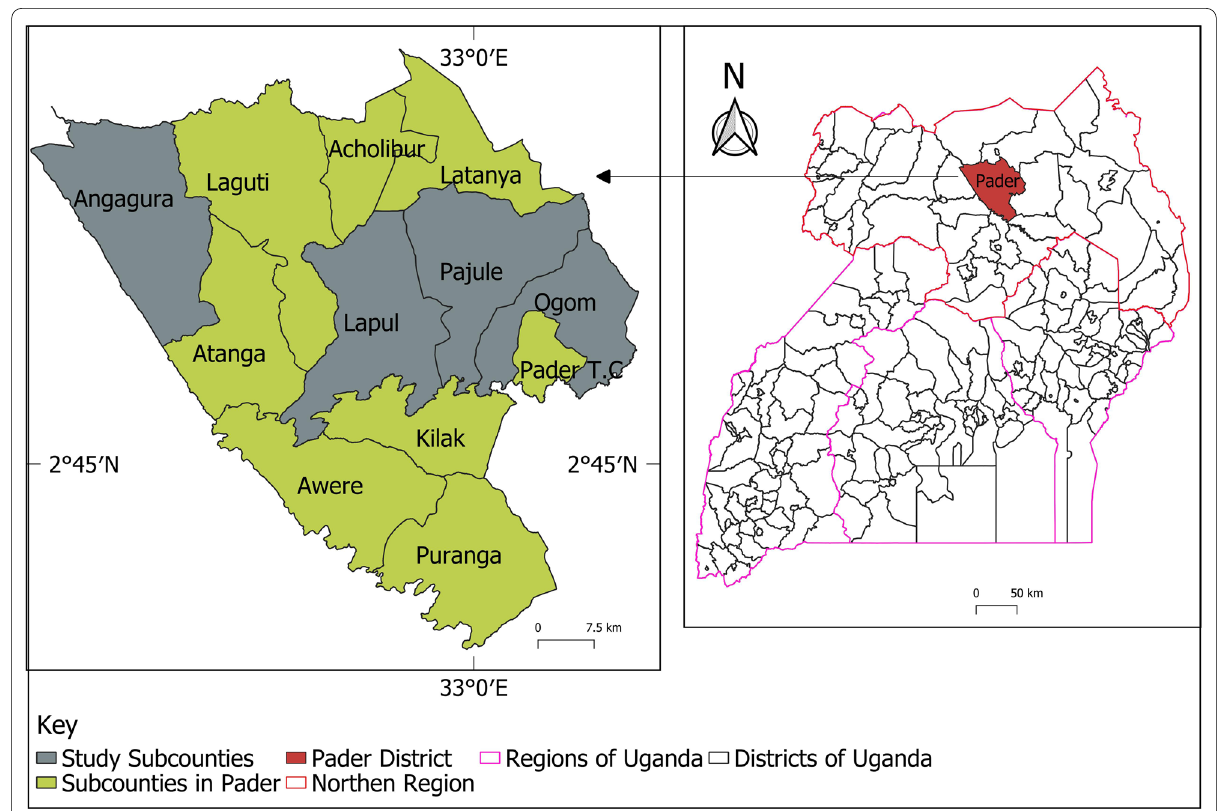
Fig. 1 Study sub-counties in Pader district, Northern Uganda (Source: QGIS 3.2